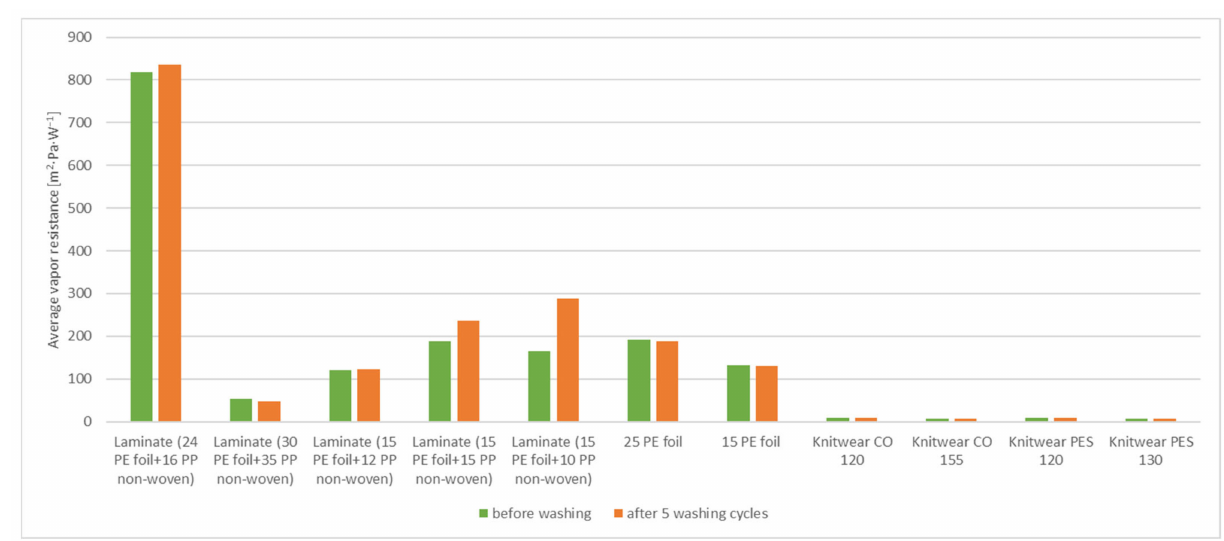
Figure 11. Average vapor resistance results: before and after 5 washing